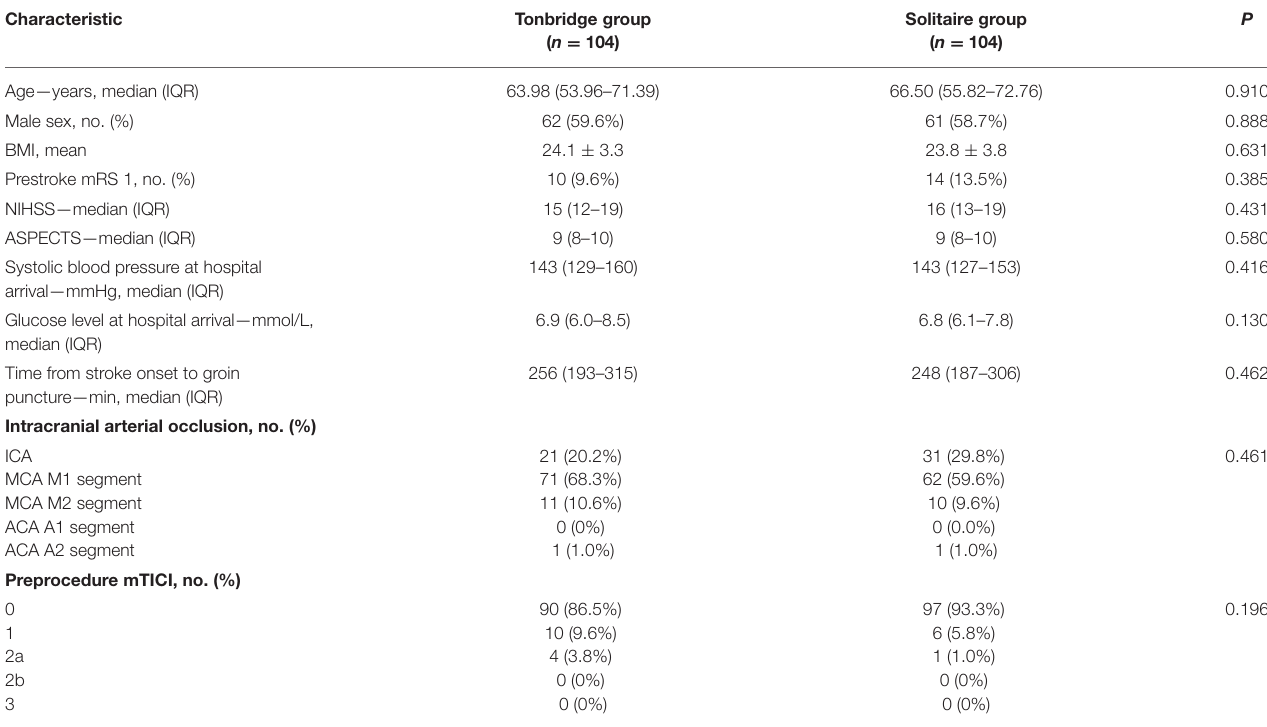
TABLE 1 | Baseline characteristics of the 208